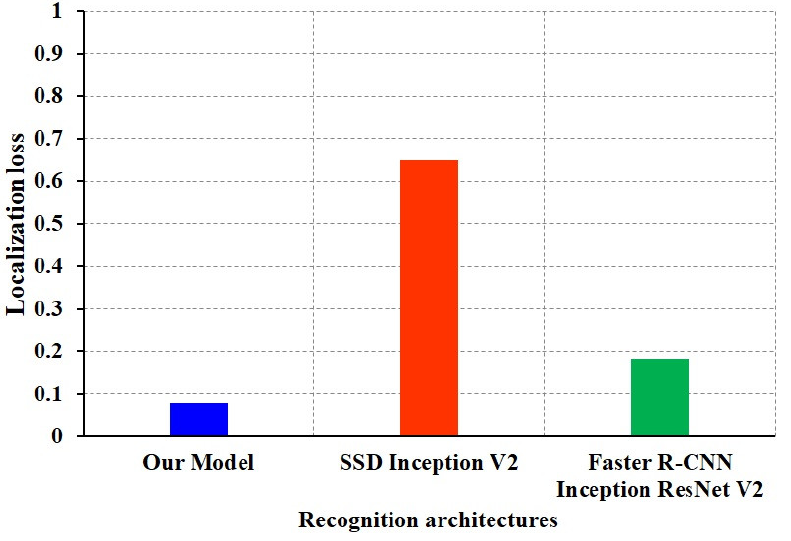
Figure 4. Localization loss comparison.